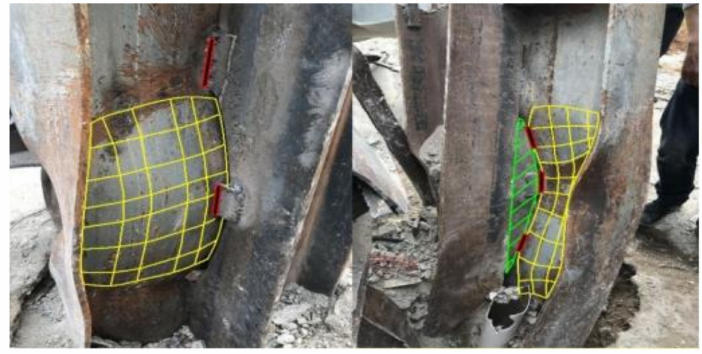
Figure 5. Buckling deformation and welding of C6 steel column. From the Investigation Report on the Collapse of Xinjia Hotel, Quanzhou City, Fujian Province.